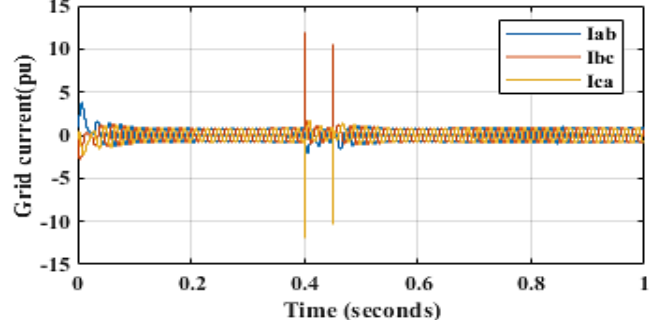
Figure 18. Grid current of the DFIG system under scenario II.